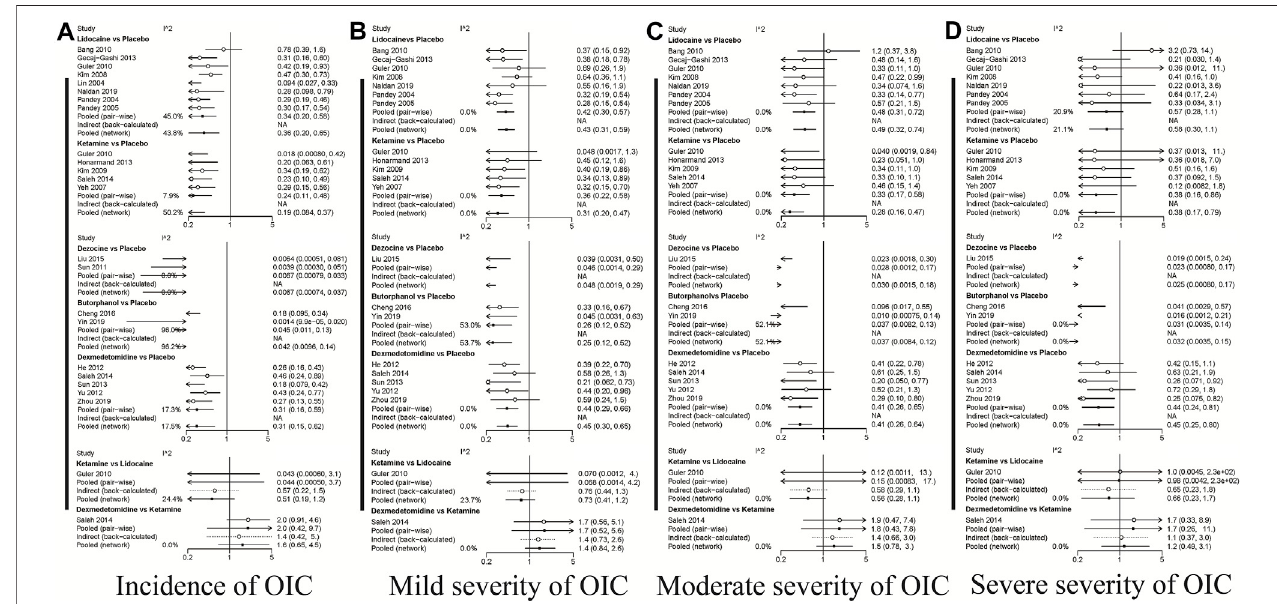
FIGURE 4 | Heterogeneity between different comparisons of drugs. (A) Incidence of OIC; (B) Mild severity of OIC; (C) Moderate severity of OIC; and (D) Severe severity of OIC.